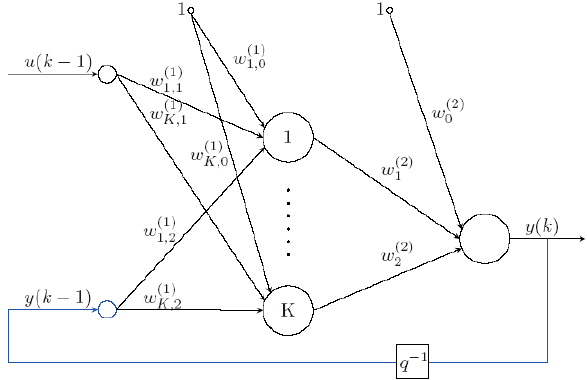
Figure 8. Architecture of Jordan neural network.